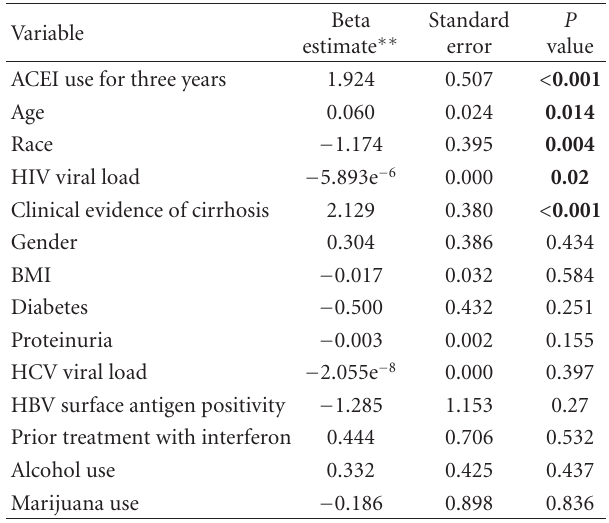
Table 5: Factors associated with an elevated Forns score on multivariate analysis ( n = 69) ∗